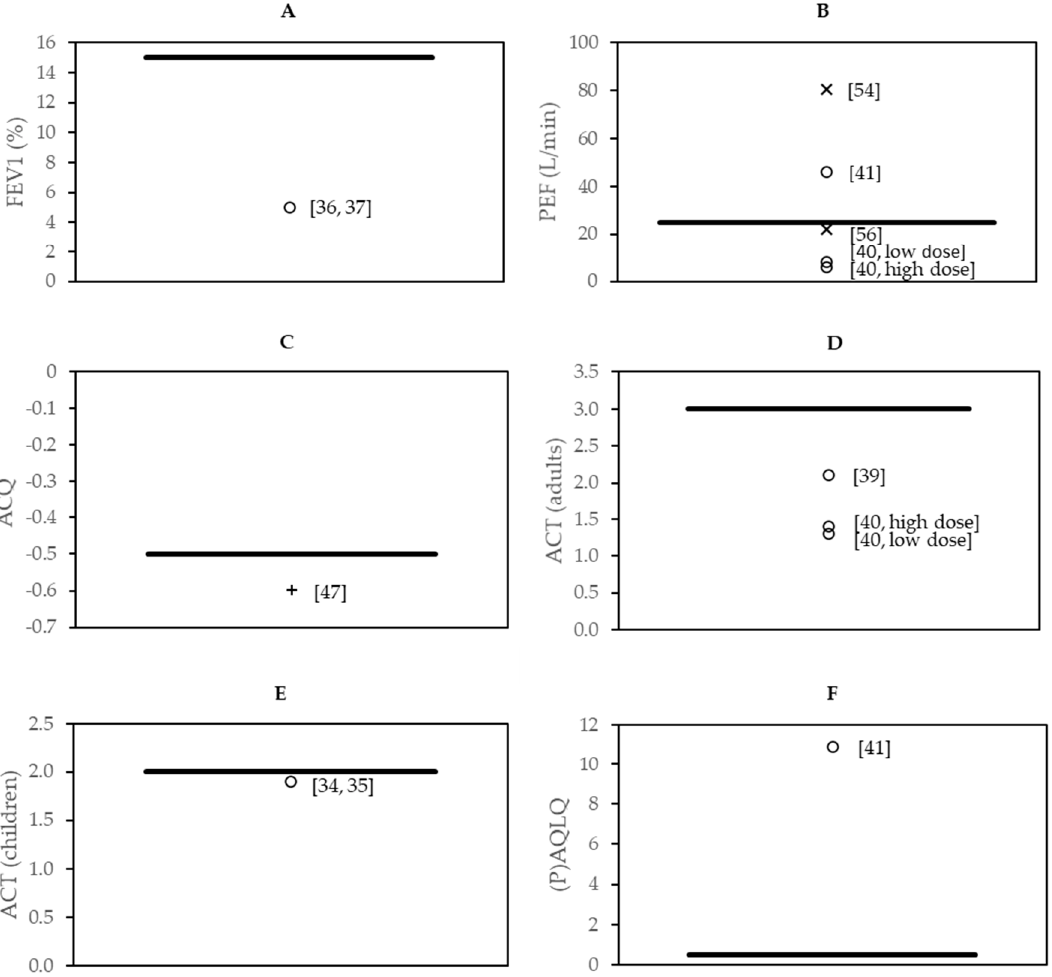
Figure 2. The magnitude of changes in asthma-related outcomes compared to the minimal clinically important di ff erence for ( A ) FEV1; ( B ) PEF; ( C ) ACQ; ( D ) ACT for adults; ( E ) ACT for children; and ( F ) (P)AQLQ. The symbols ( ◦ = herbs, herbal mixtures and extracts; x = omega-3 LCPUFA; + = weight loss) represent individual studies, and the line ( − ) indicates the minimal clinically important di ff erence. Reference numbers for individual studies are noted next to the corresponding symbol.